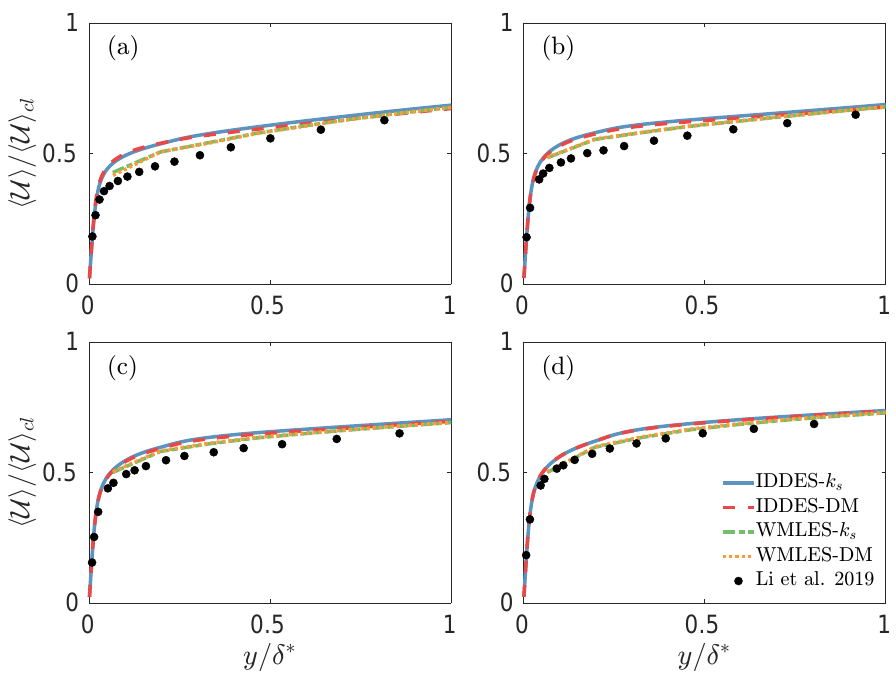
Figure 6. Mean velocity profiles in outer units at ( a ) 3%, ( b ) 10%, ( c ) 19% and ( d ) 63% of the length of the smooth strip compared with experimental results [14].